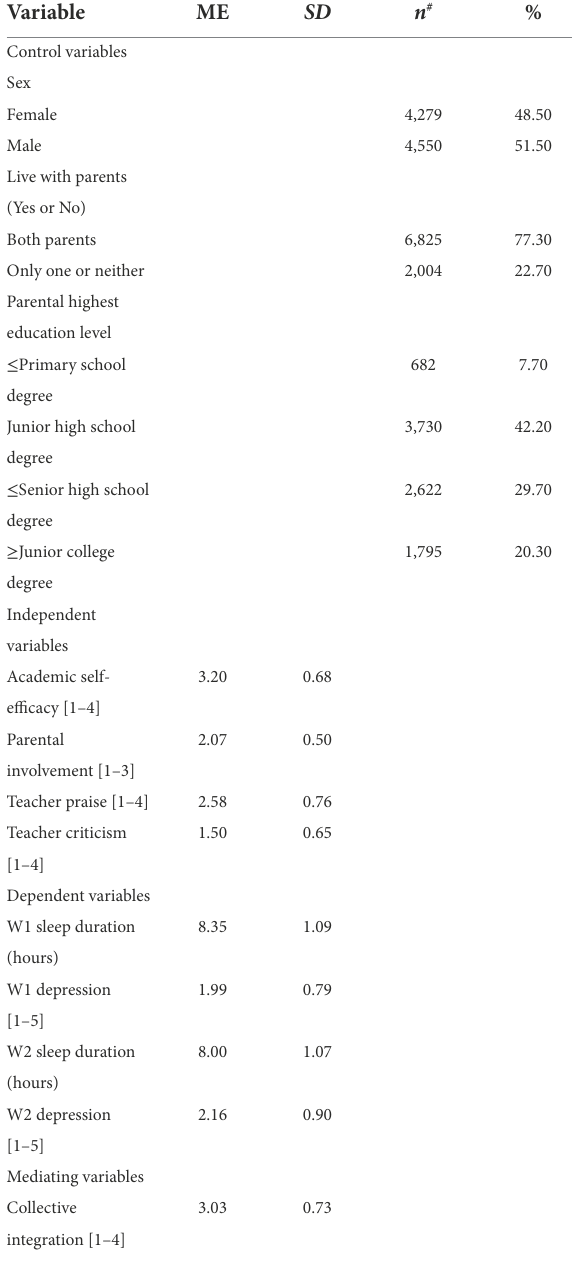
TABLE 1 Demographic characteristics of participants and descriptive statistics of key variables. ( N = 8829).